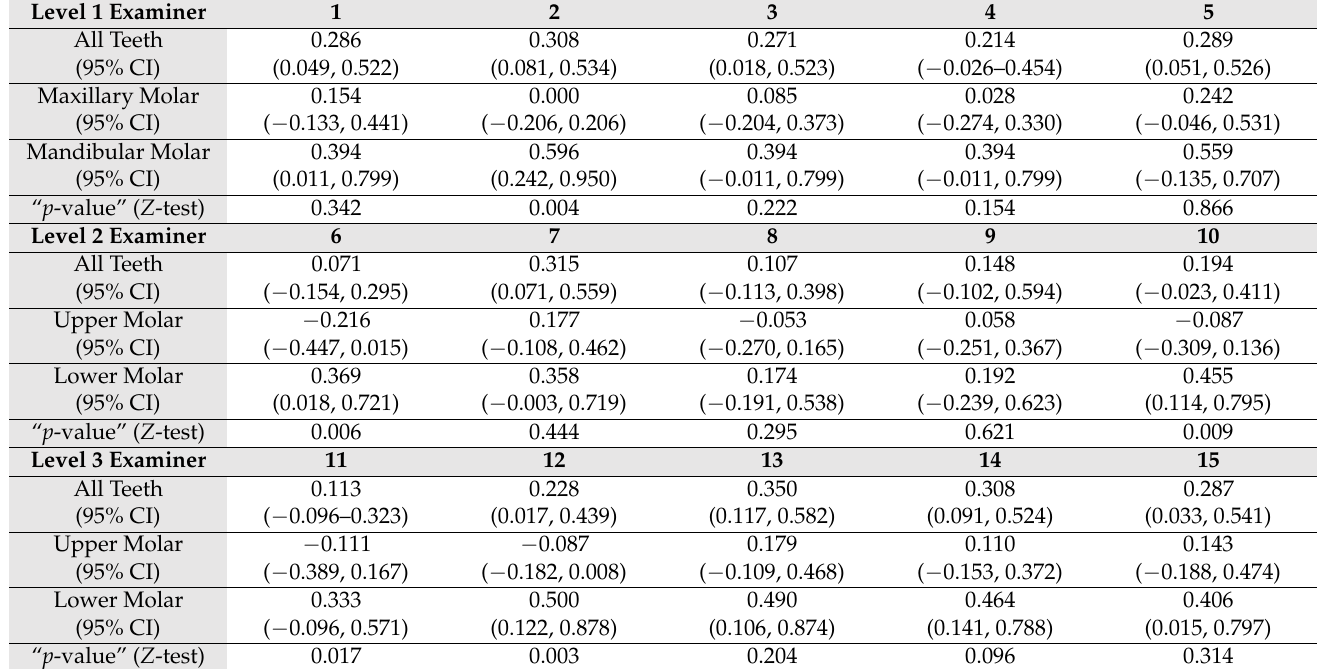
Table 2. Linear weighted kappa for vertical furcation subclassification determined by conventional modality against